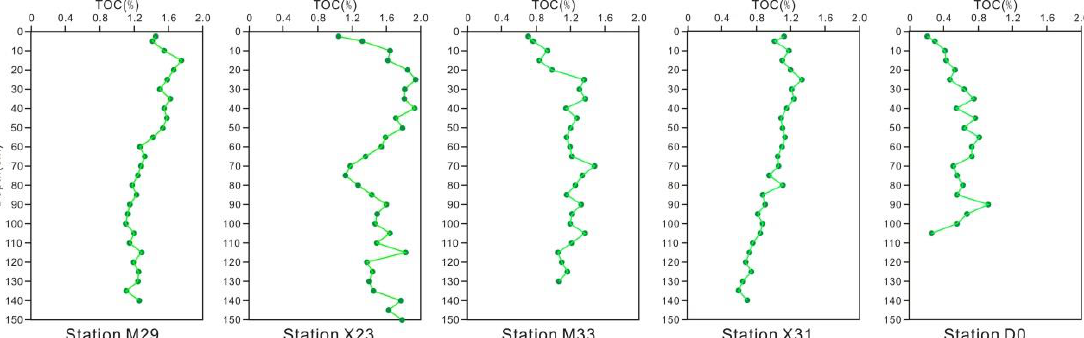
Figure 4. Component profiles of TOC in sediments.